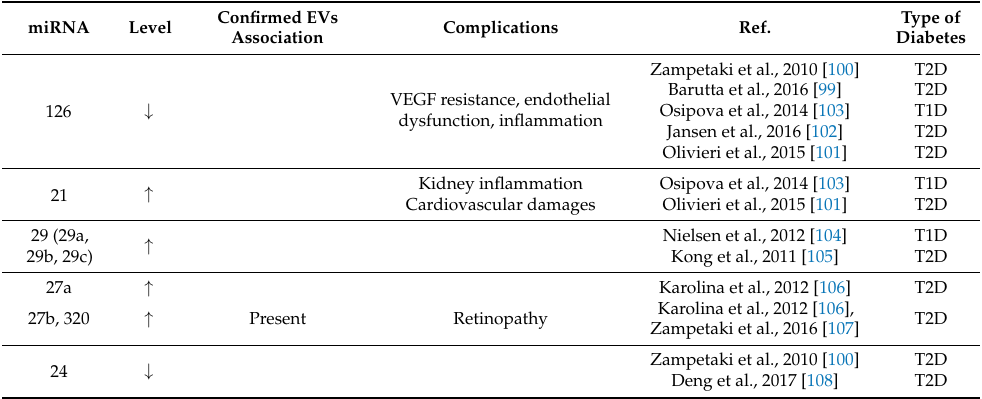
Table 1. MiRNAs and EV-associated miRNAs in T1D and T2D. Most frequently detected dysregulated miRNAs in T1D and T2D patients with disease-associated